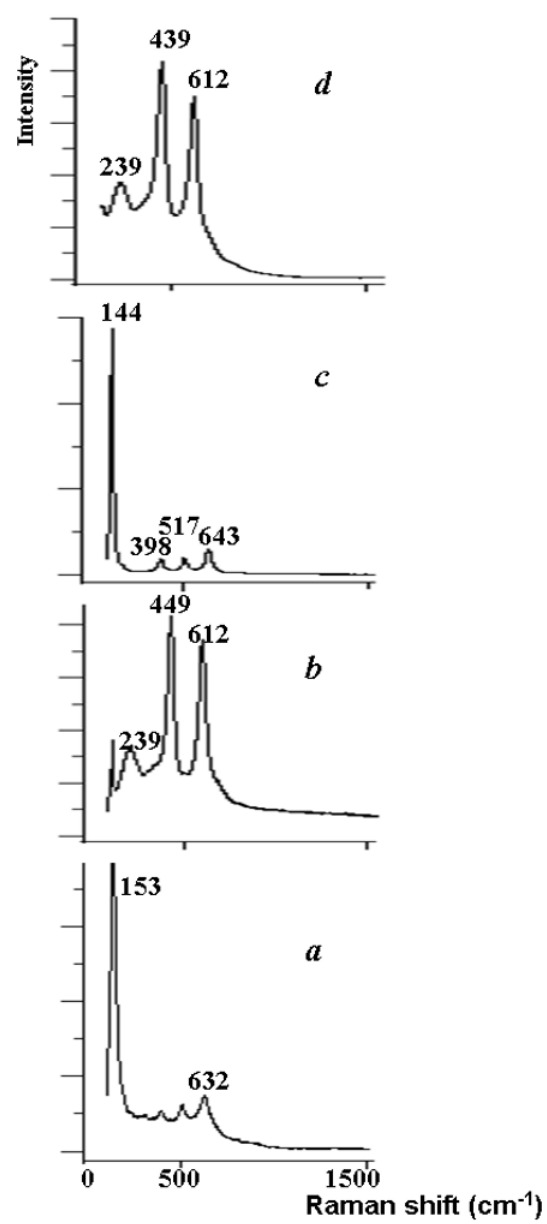
Figure 2. Raman spectra for different TiO anatase+rutile (b), anatase (c) rutile